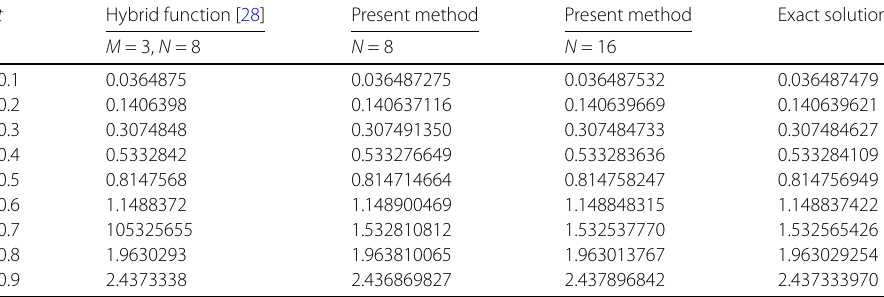
Table 3 Comparison of the numerical results of the hybrid function and the present method for Example